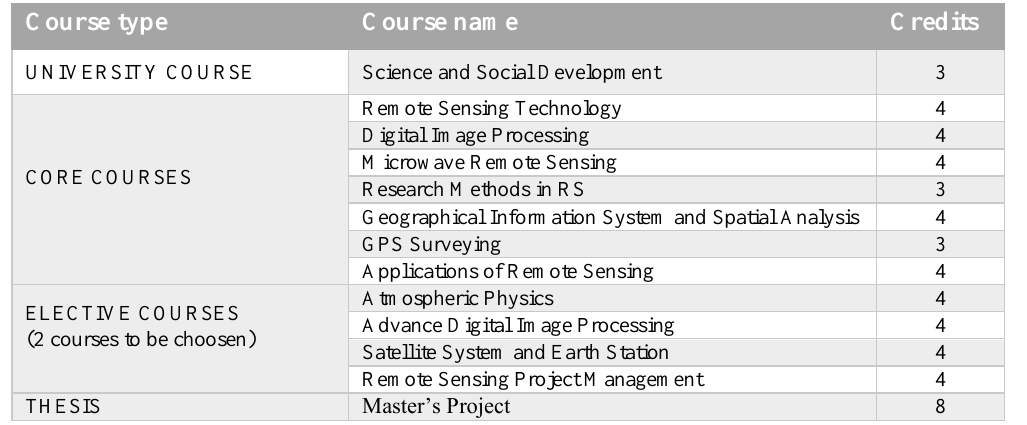
Table 4. Curriculum of M.Sc. in Remote Sensing. (by course work) at UTM